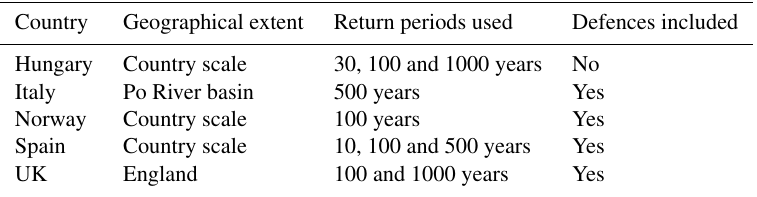
Table 1. Characteristics of the flood hazard maps used in the validation exercise. The links for downloading the maps are provided in the Data availability section.